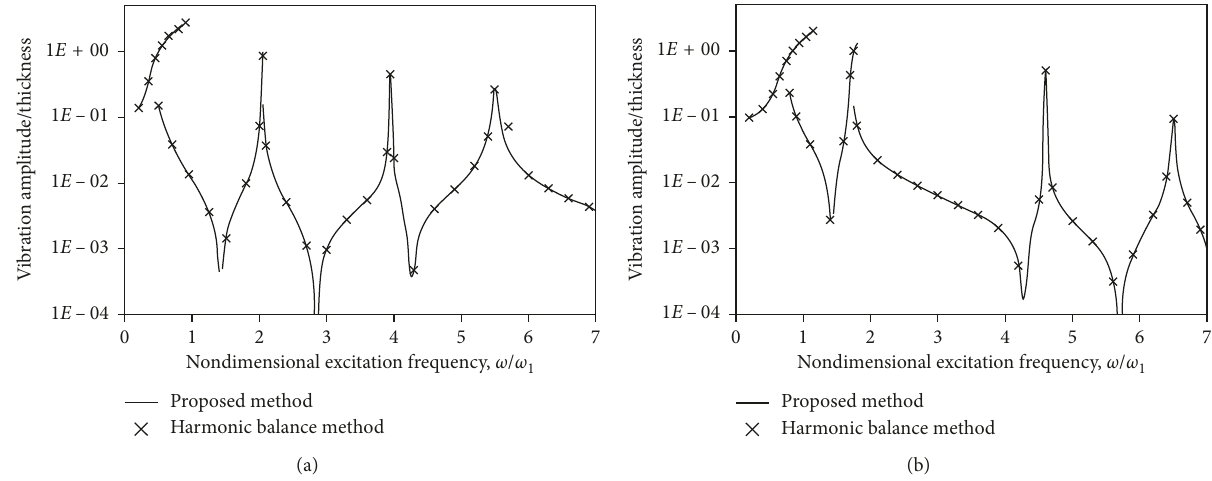
Figure 2: (a) Comparison of the symmetric and (b) antisymmetric vibration amplitude results from the proposed method and classical harmonic balance method ( κ